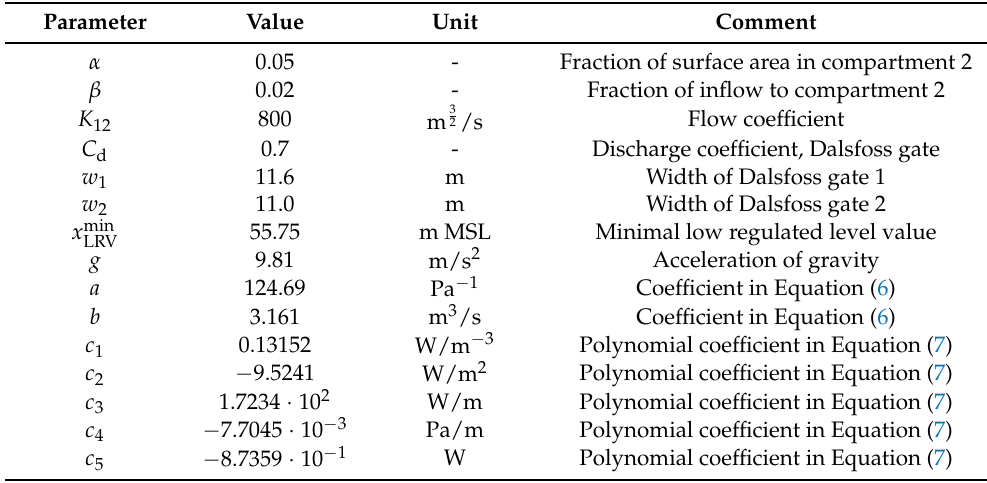
Table 1. Parameters for Lake Toke